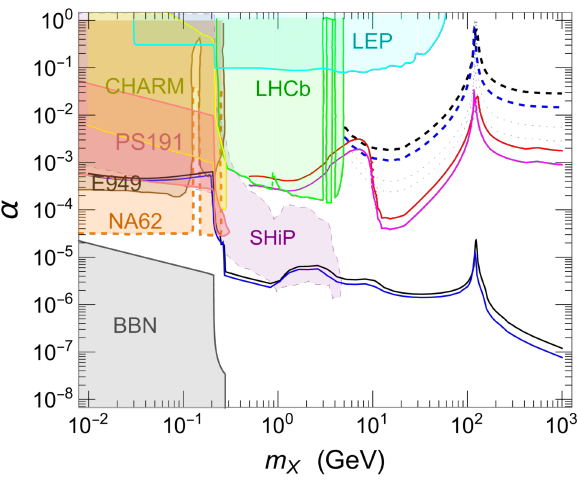
Figure 8 . Constraints on the m X − α parameter space. (1) From the hidden scalar search, colored regions with solid boundaries are excluded by experiments denoted in the plot, while colored regions with dashed boundaries indicate sensitivity projections. For brevity, r (= m S /m X ) = 1 . 01 is used. (2) With r = 1 . 01 (black) and 1.05 (blue), the PandaX-4T [4] bound and LZ projected sensitivity [25] are respectively shown by the dashed and dotted lines, corresponding to use of the local DM density ρ (cid:12) = 0.4 GeV/cm 3 . The SM neutrino floor [34] is denoted by the red (or magenta) solid curve corresponding to r = 1 . 01 (or 1.05). For comparison, the lower bounds of α , keeping the hidden sector in equilibrium with the thermal bath before freeze-out, with r = 1 . 01 (black solid curve) and 1 . 05 (blue solid curve) are